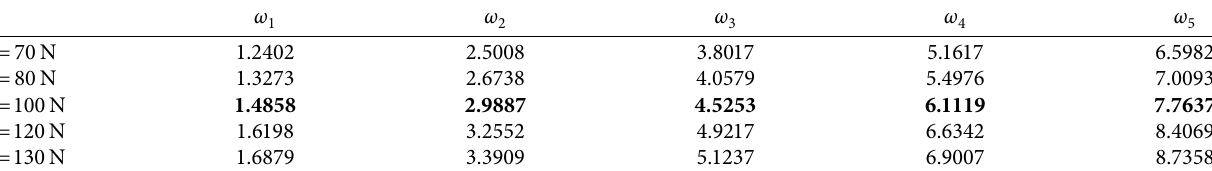
Table 6: Natural frequencies of the TTR test model(Hz).